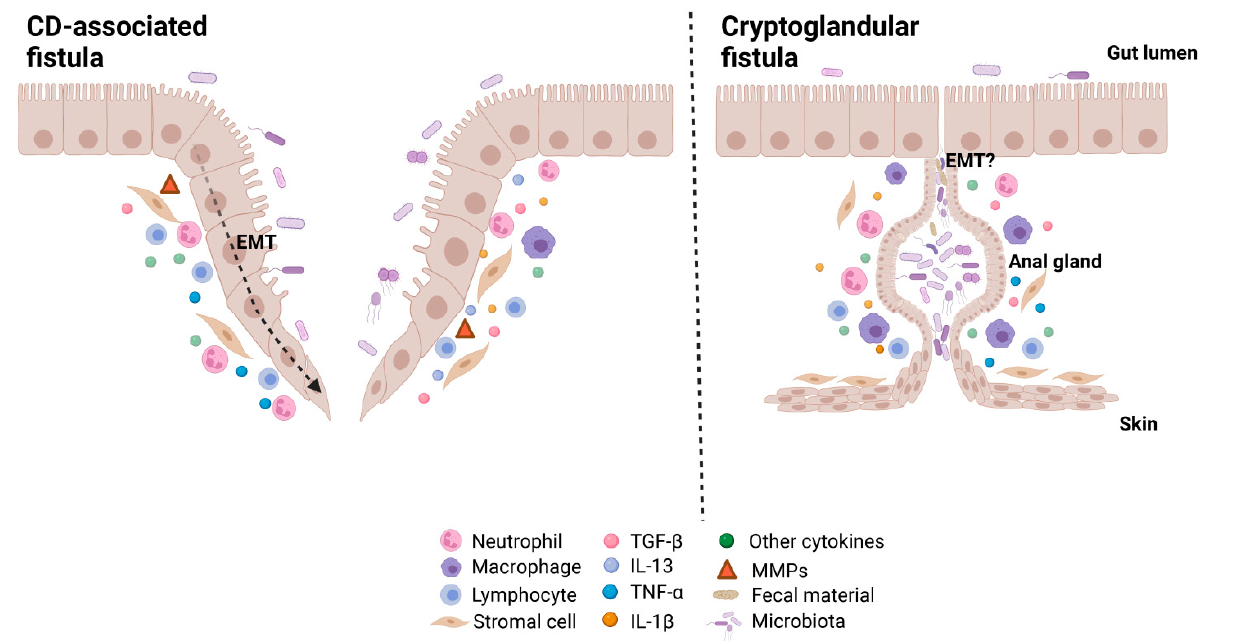
Figure 2. Proposed mechanism of the pathogenesis of CD-associated perianal fistulas and cryptog- landular perianal fistulas. EMT: epithelial-mesenchymal transition; TGF- β : transforming growth factor beta; IL-13: interleukin 13; TNF: tumor necrosis factor; IL-1 β : interleukin 1 beta; MMPs: matrix